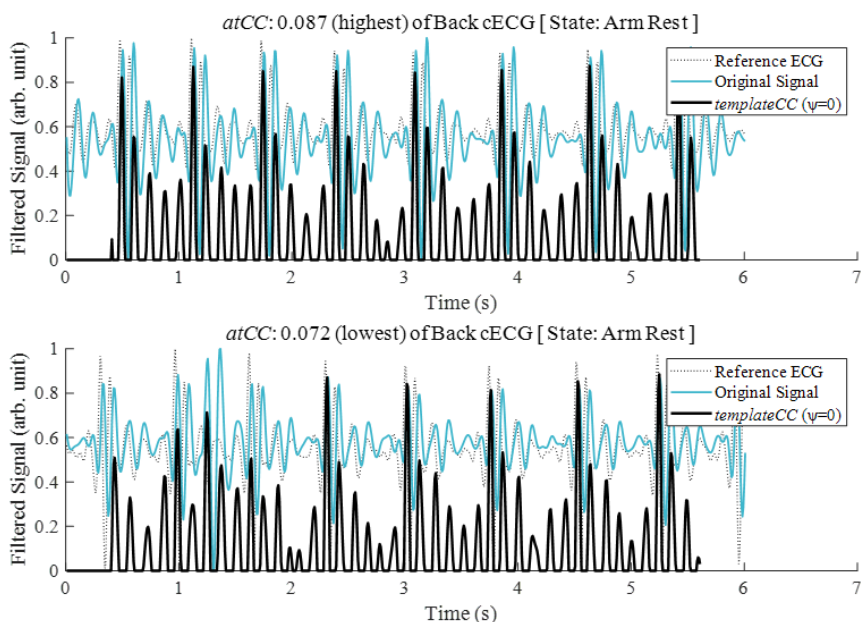
Figure 5. The highest ( upper figure ) and lowest ( lower figure ) values of the averaged template CC ( atCC ) derived from the original back cECG for resting states after completion of a motion task by a participant (p7).